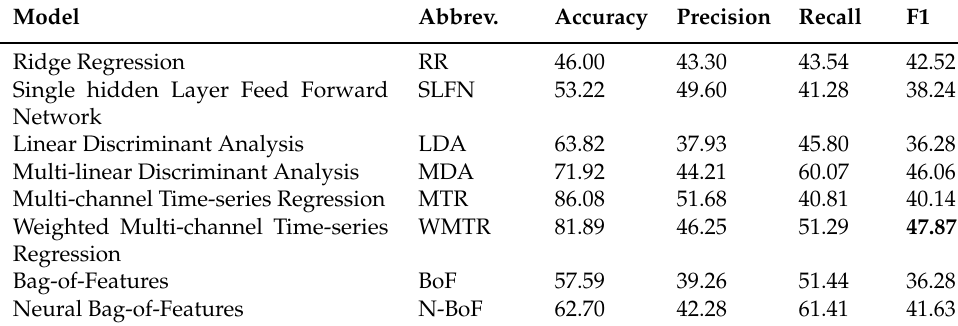
Table 4. Performance comparison of the methods applied in